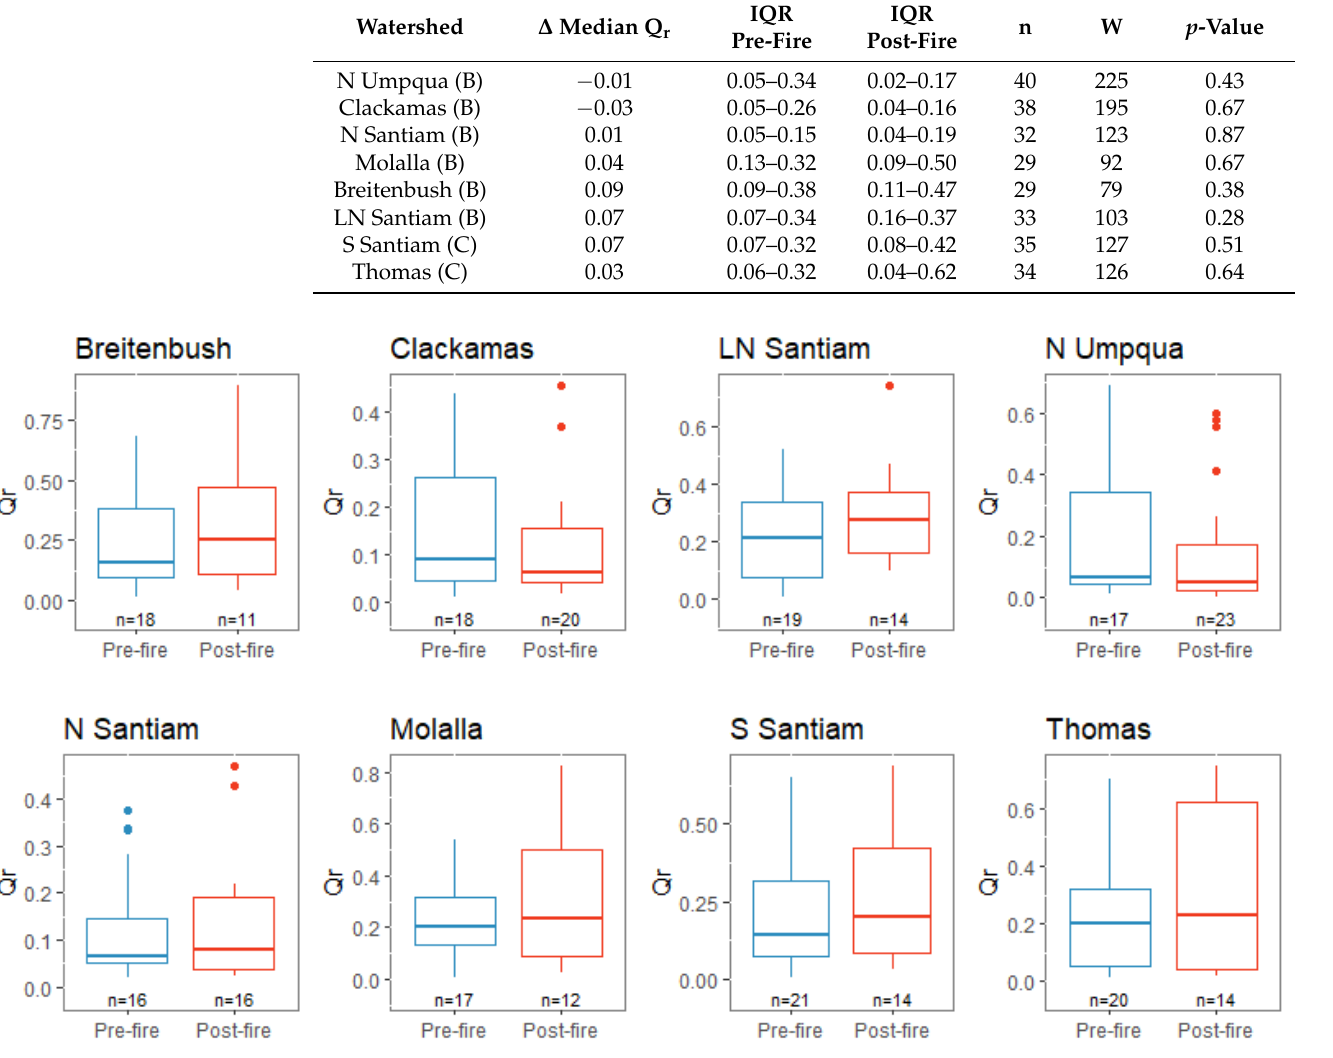
Table 4. Q r results of Mann–Whitney U test and change in Q r values for six burned watersheds (B) and two controlled watersheds (C). The significance level was considered p -value < 0.10.